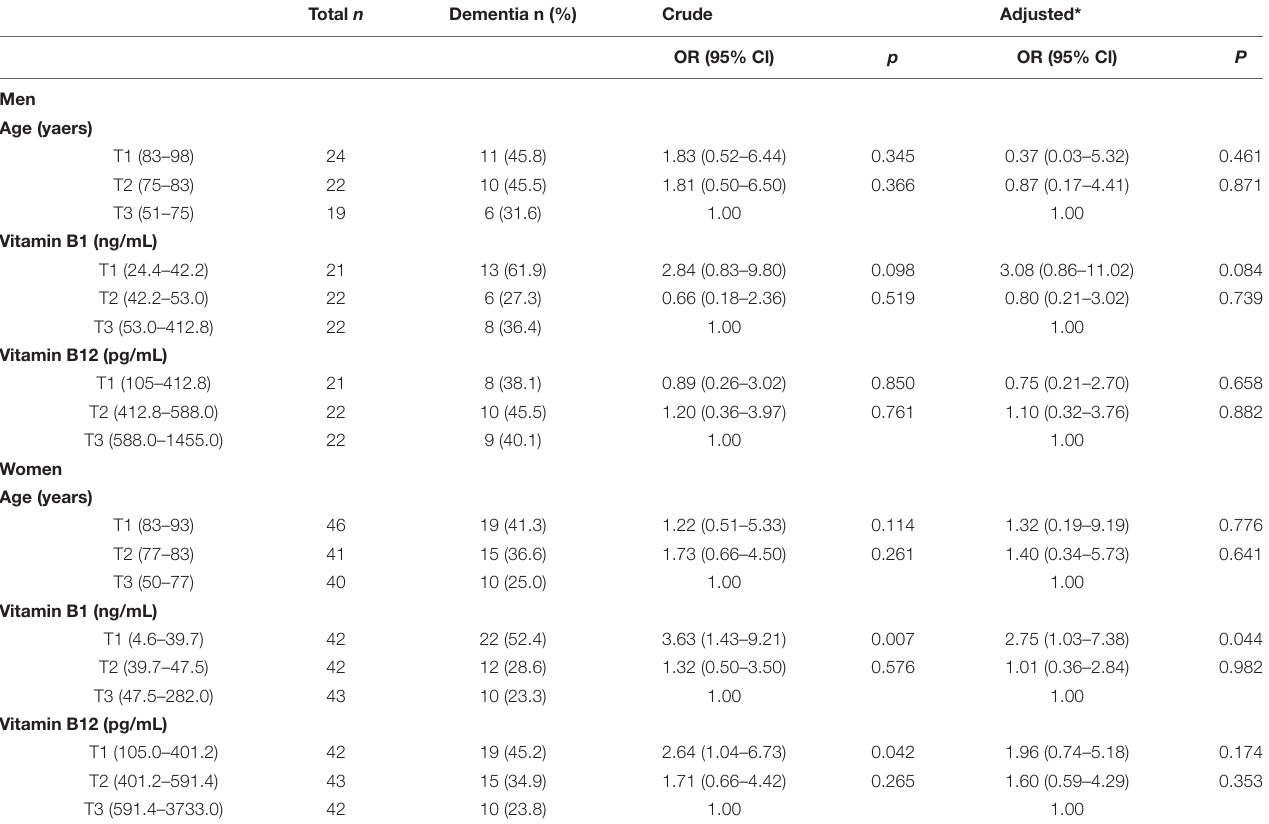
TABLE 6 | Associations of vitamin B1 and vitamin B12 with dementia defined by HDS-R ≤ 20 in each sex. Total n Dementia n (%) Crude Adjusted* OR (95% Cl) p OR (95% Cl)